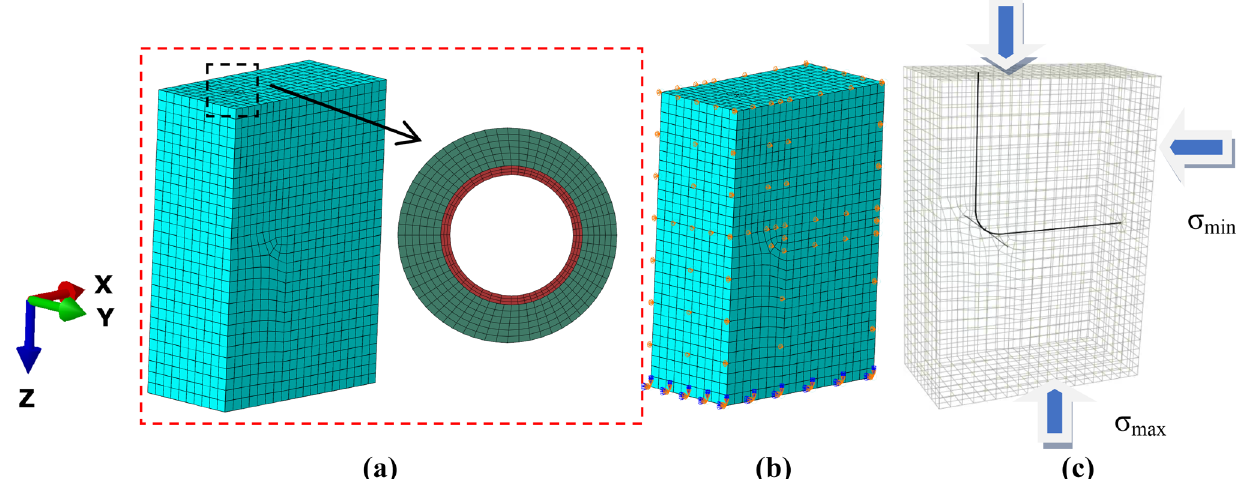
Fig. 3 Model building results. a Three-dimensional finite element model of whole string, meshing. b Three-dimensional finite element model of whole string, boundary condition. c Three-dimensional finite element model of whole string, 3D perspective